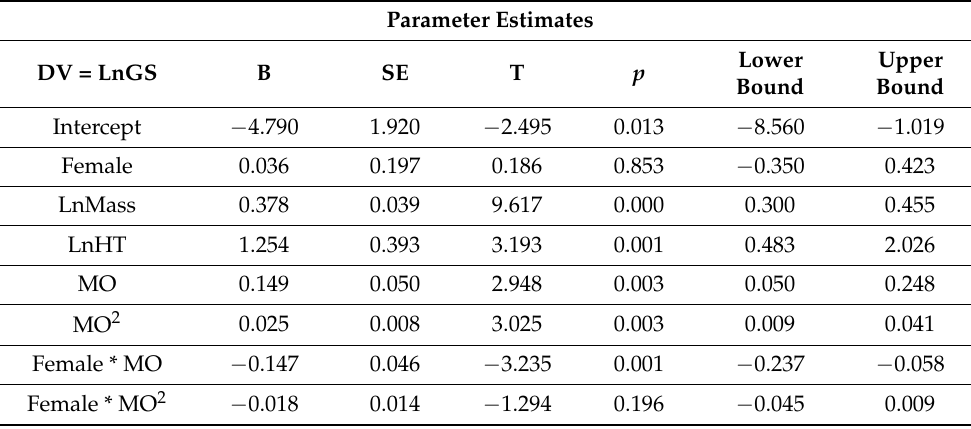
Table 5. The fitted ANCOVA parameters predicting log-transformed grip strength Ln(GS) and